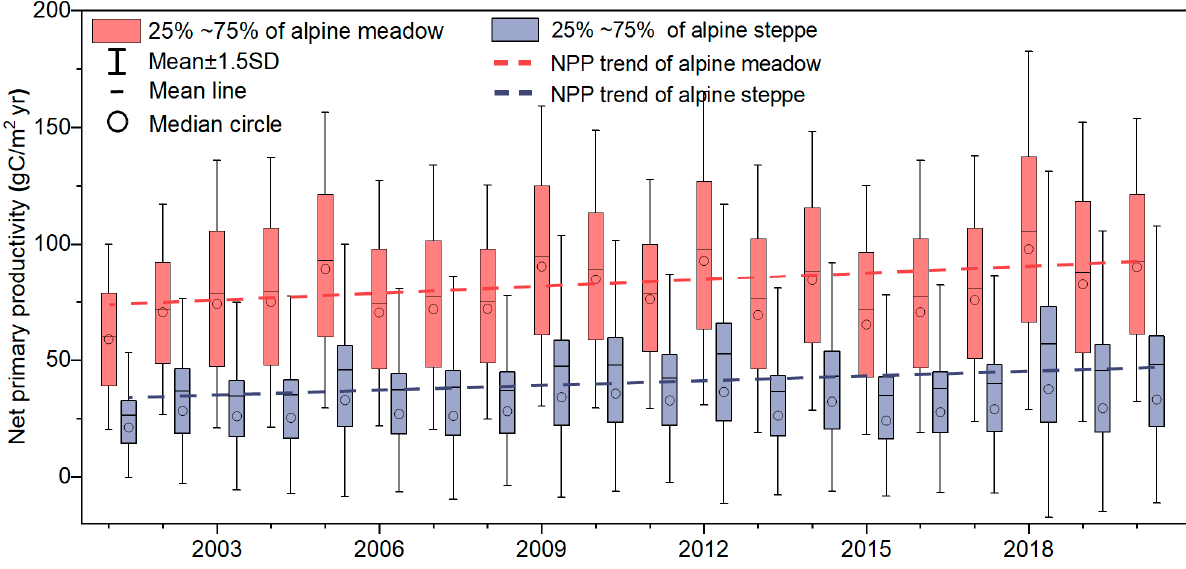
Figure 3. The net primary productivity of the alpine meadow and alpine steppe from 2001 to 2020. To illustrate the spatial distribution of the estimated NPP, this paper performed the average NPP of the whole TRH region from 2001 to 2020 (Figure 4a). To illustrate the spatial distribution trend of the estimated NPP, this paper calculated the average NPP and standard deviation values along the latitude and longitude (Figure 4(a1,a2)). To illustrate the distribution gathering area of the estimated NPP, this paper plotted the area within each basic unit with 20 gCm − 2 yr − 1 as the step size (Figure 4(a3)). To view the changing trend of the NPP in the past 20 years pixel by pixel, the changing trend of the estimated time series NPP was drawn by combining the senSlope and MK (Figure 4b). At the same time, to explore whether the changing trend is persistent, this paper drew the changing character of the estimated time series NPP based on the change trend map and combined it with the Hurst index (Figure